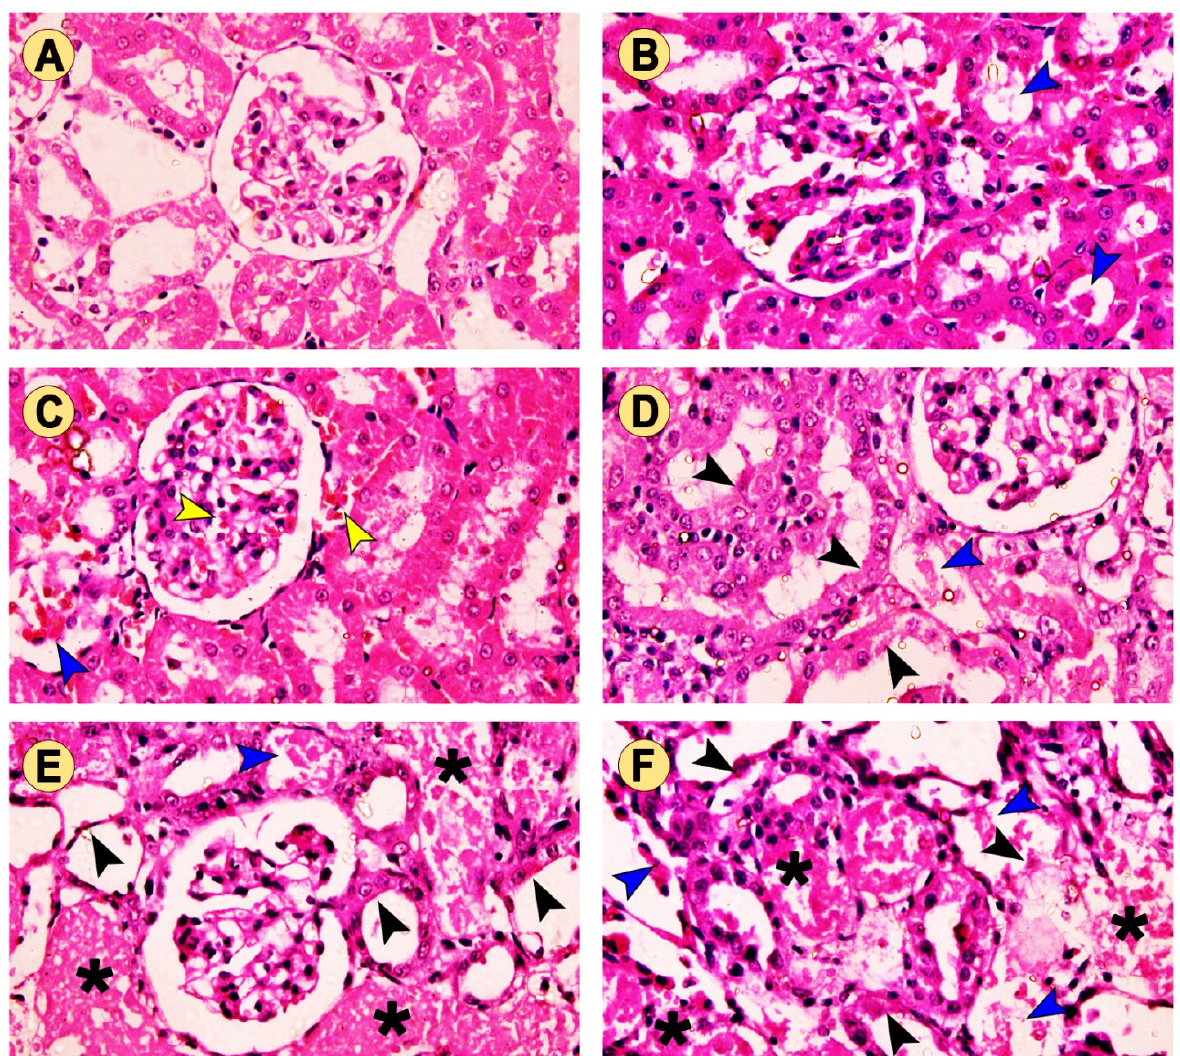
Figure 4. The effect of TG and GM combined treatment on the renal histoarchitecture. ( A ) The control group presented normal renal corpuscle and proximal and distal convoluted tubules. ( B ) The TG7 group showed mild intertubular eosinophilic debris (blue arrow) in the lumina of some renal tubules. ( C ) The TG14 group showed congestion of the glomerular tufts and intertubular blood capillaries (yellow arrow) as well as mild intratubular eosinophilic debris (blue arrow). ( D ) The GM group exhibited moderate intratubular eosinophilic debris (blue arrow) and degenerated tubular epithelium (black arrow). ( E , F ) The TG7+GM and TG14+GM groups, respectively, showed severely degenerated tubules with an accumulation (asterisk) of dead tissues within their lumina in a dose-dependent manner (H&E stain, 400× magnification).